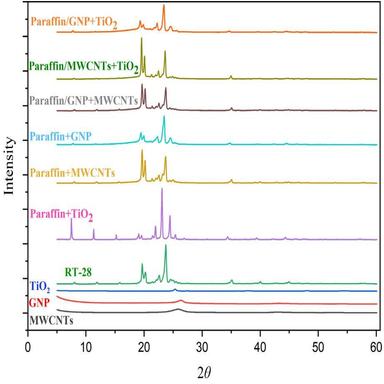
XRD patterns of distinct single and hybrid nano-PCMs.